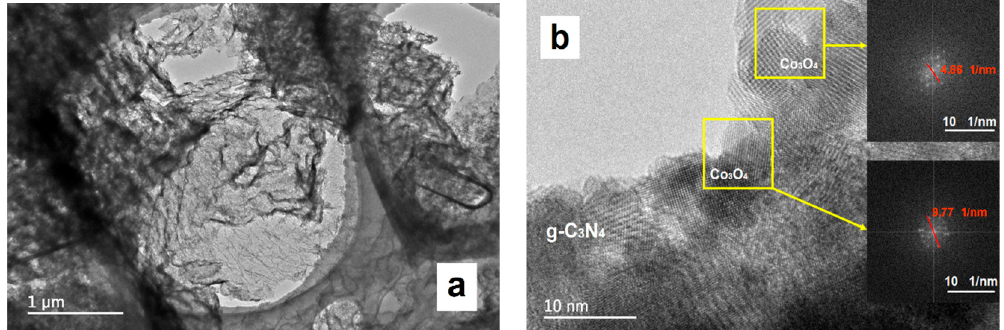
Figure 3. ( a ) TEM image of CNNS and ( b ) TEM image and selected area electron diffraction (SAED) analysis of 12Co 3 O 4 /CNNS.